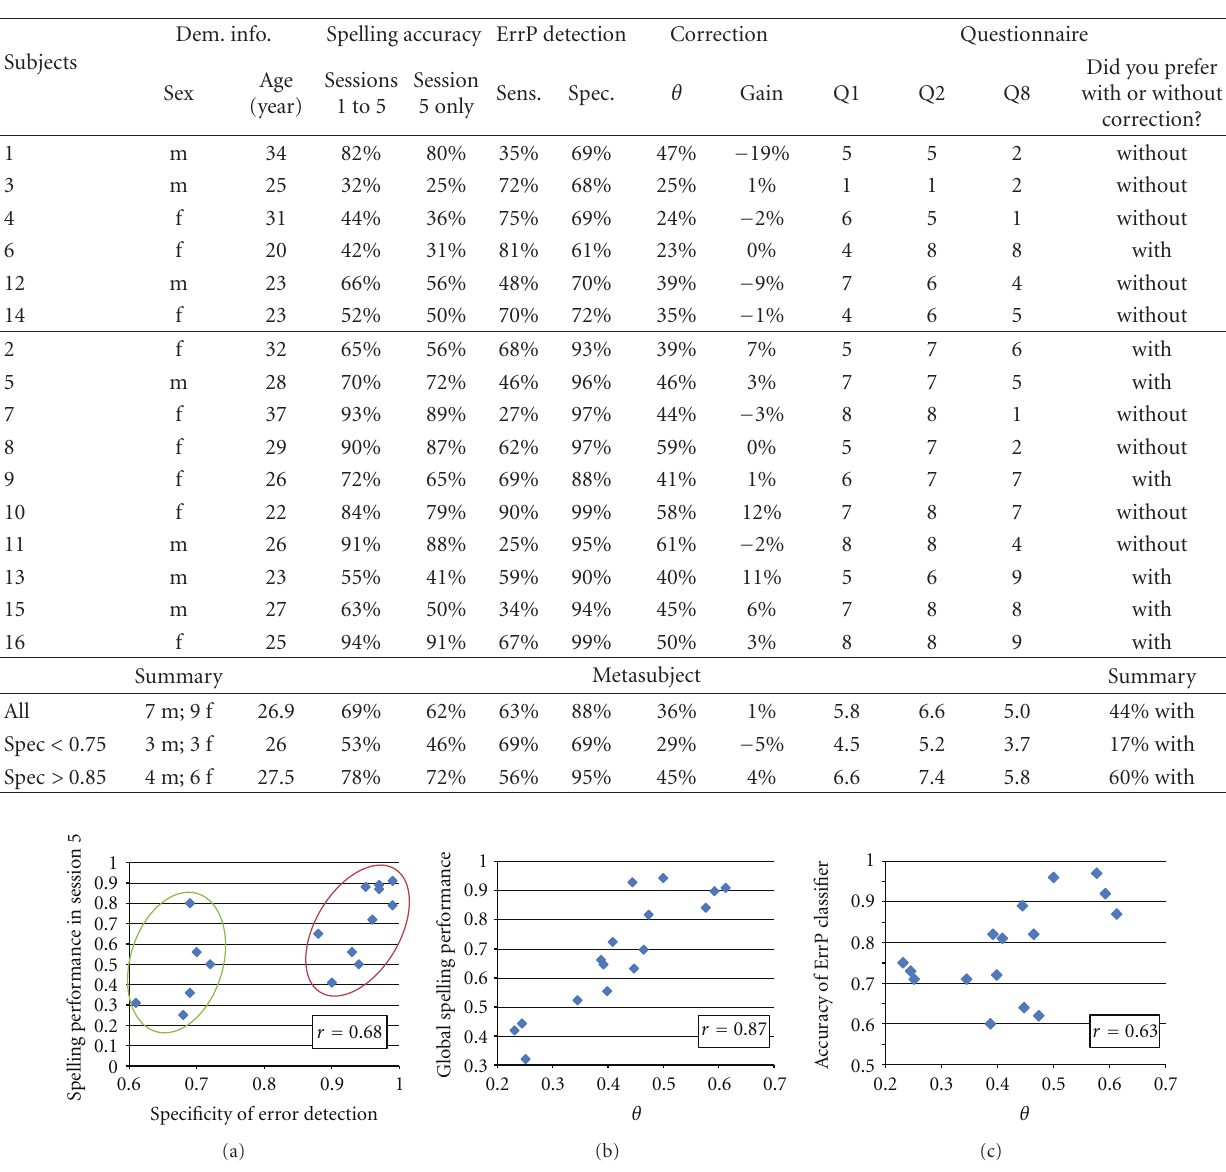
Figure 5: (a) Correlation between the spelling accuracy (rate of correctly spelled letters) in session 5 (without considering the correction) and specificity of error detection. The green circle includes participants with low specificity while the red one includes participants with high specificity. (b) Global spelling accuracy as a function of θ . (c) Accuracy of error detection as a function of θ . Each diamond represents a participant, and R values represent correlation coe ffi